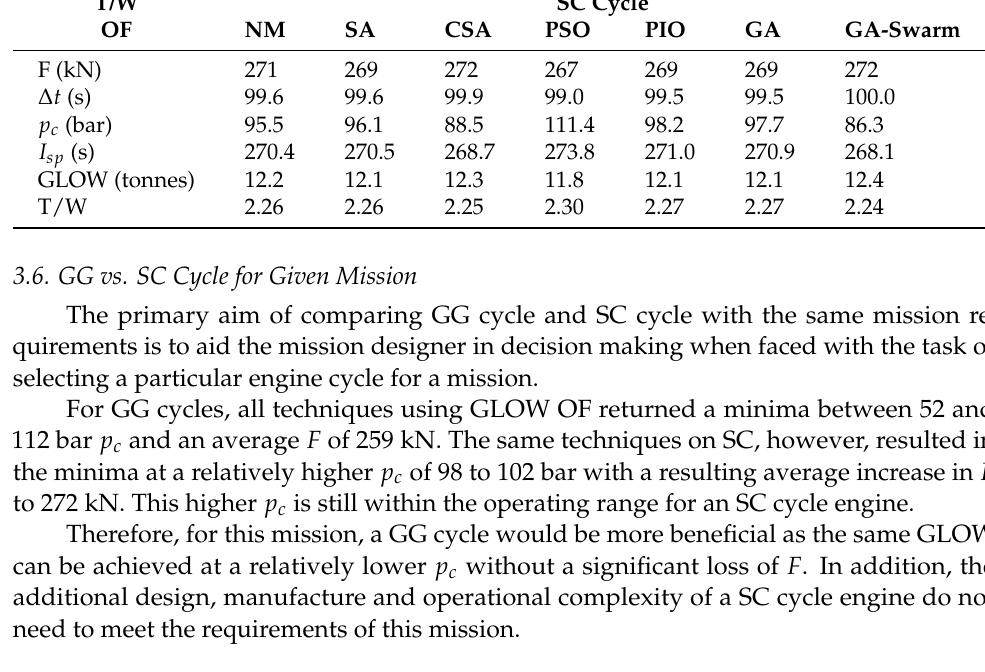
Table 14. Values of Variables at max T/W for each technique. T/W